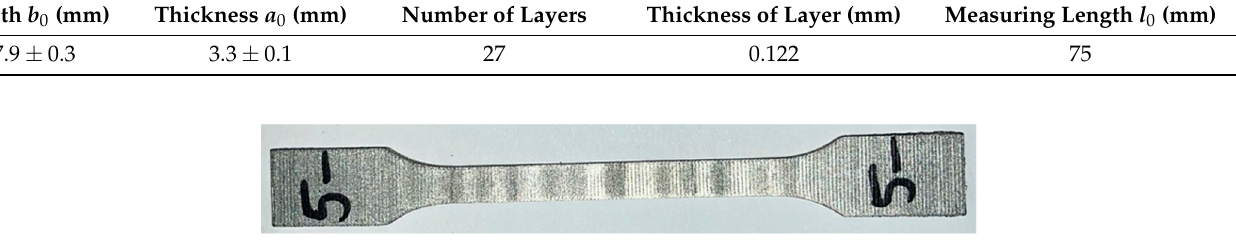
Figure 6. Example of tested samples (lamination angle 90 (cid:2925) ) Table 2. Dimensions of tested